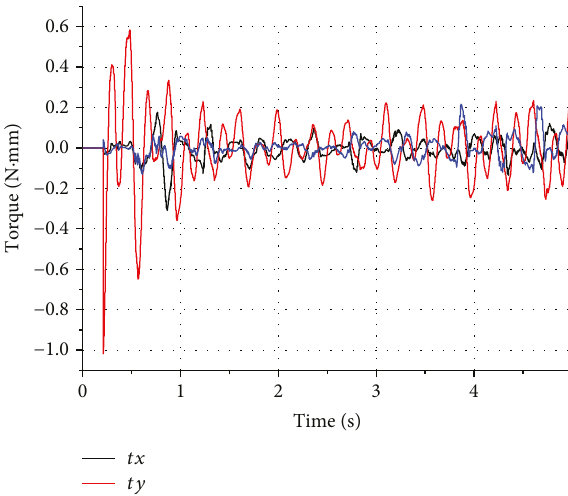
Figure 17: The pneumatic of adapter 3.